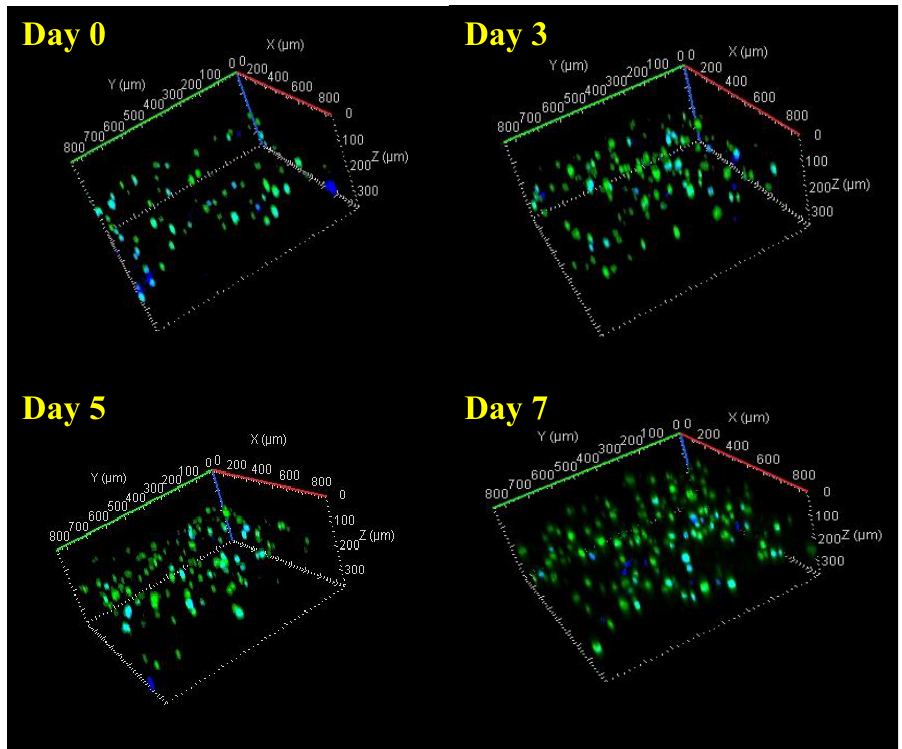
Figure 6. Confocal images of bioprinted CH–GE–PEG cell-laden constructs throughout 7 days showing live (green) and total number of the cells (blue). All images shown in this graph are representative of three independent experiments with similar results.